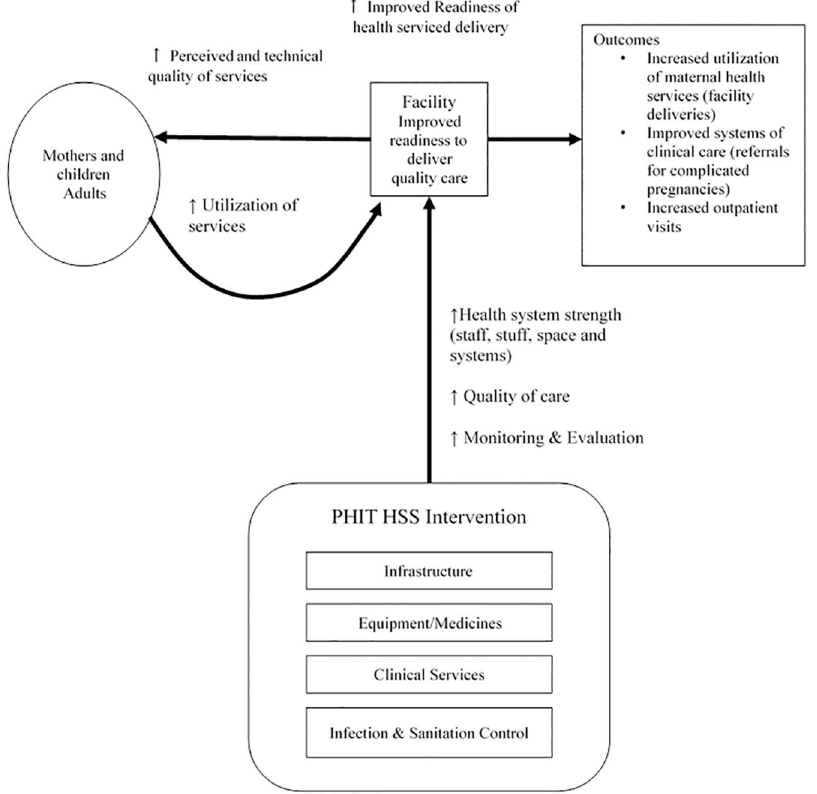
Fig 1. Rwanda Population Health Implementation and Training health systemsstrengthening evaluation conceptual framework.